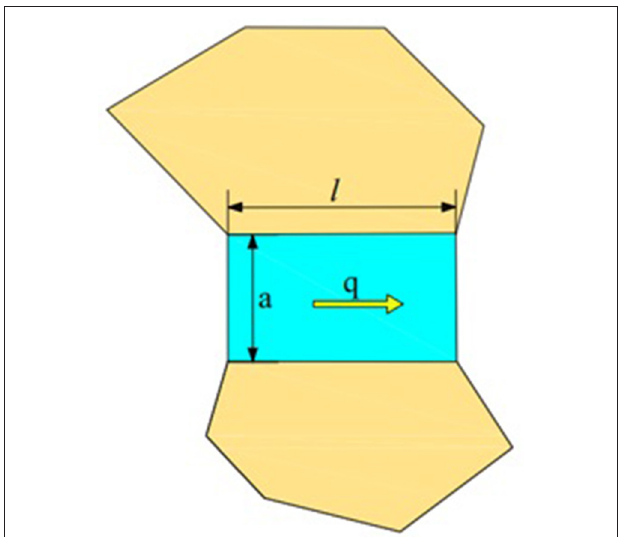
FIGURE 2 | Simulation